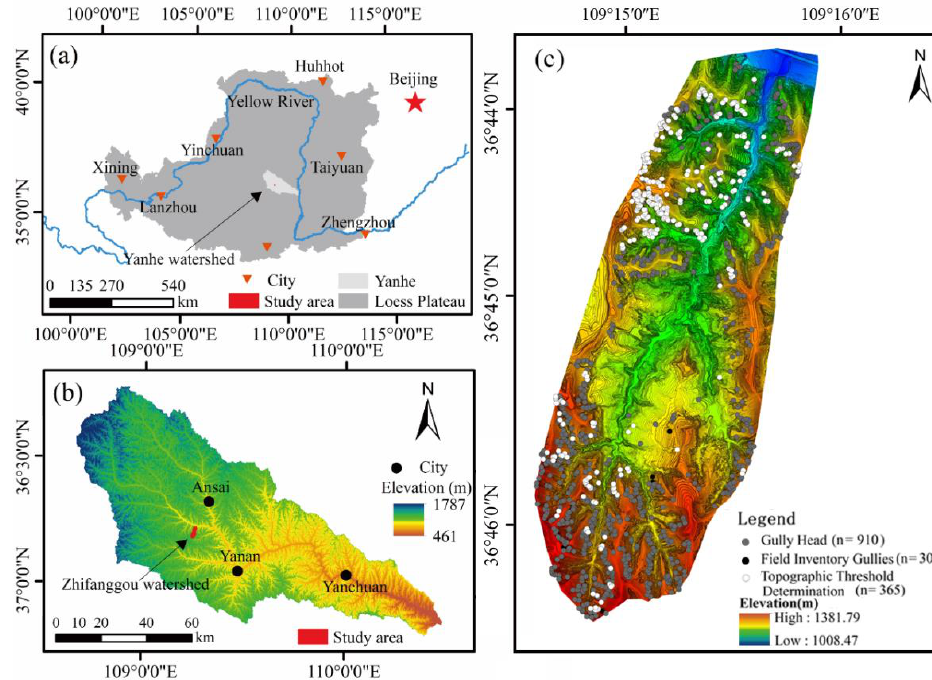
Figure 1. Location of Zhifanggou watershed on the Loess Plateau ( a ), Yanhe watershed ( b ), and the maps for elevation and gully head position ( c ).